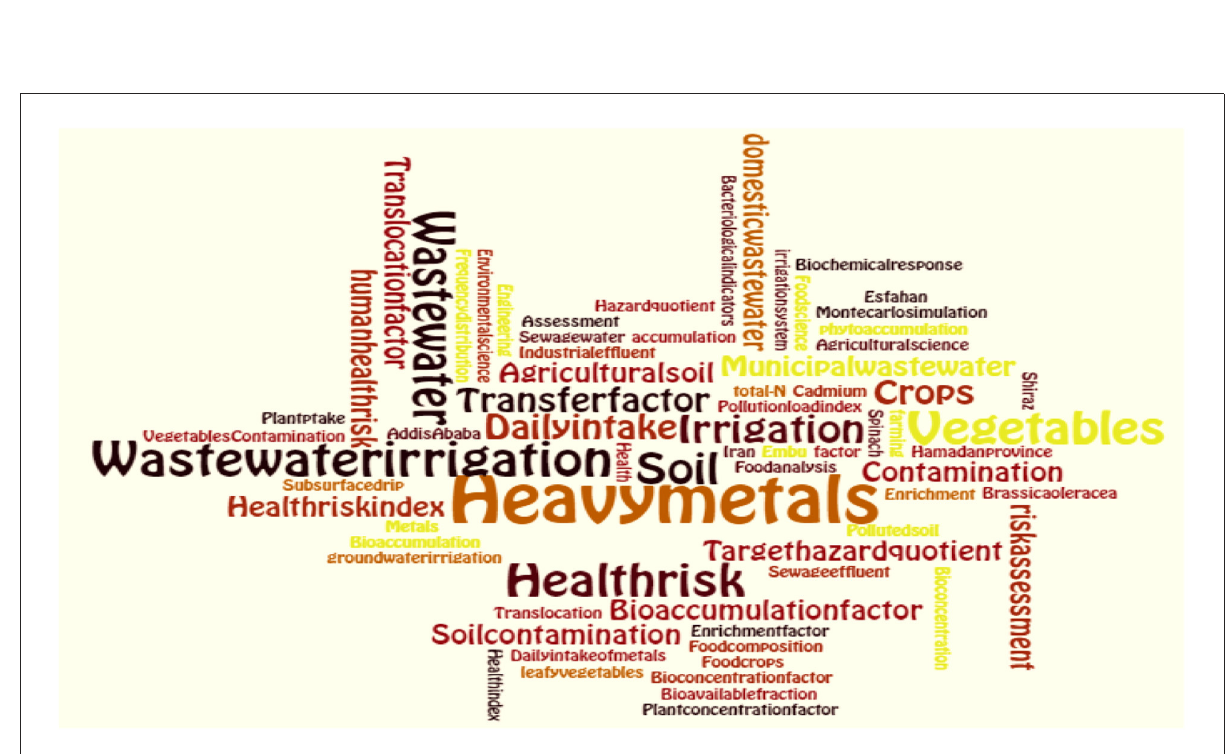
FIGURE3 Word cloud of 91 keywords used by the authors in the selected